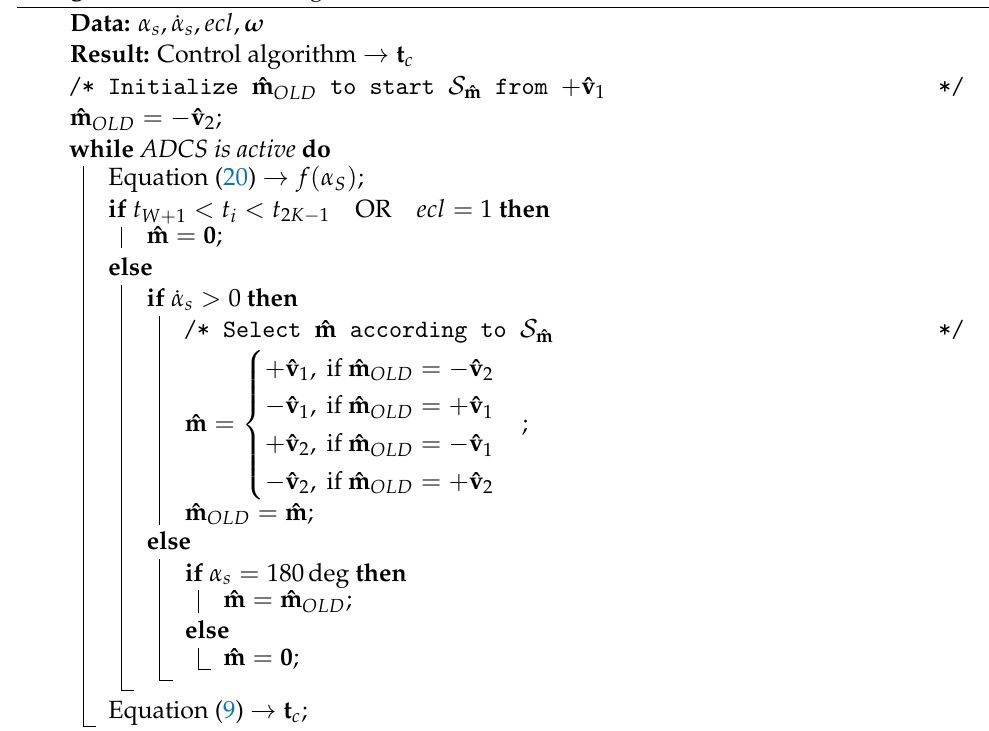
Algorithm 2: Control